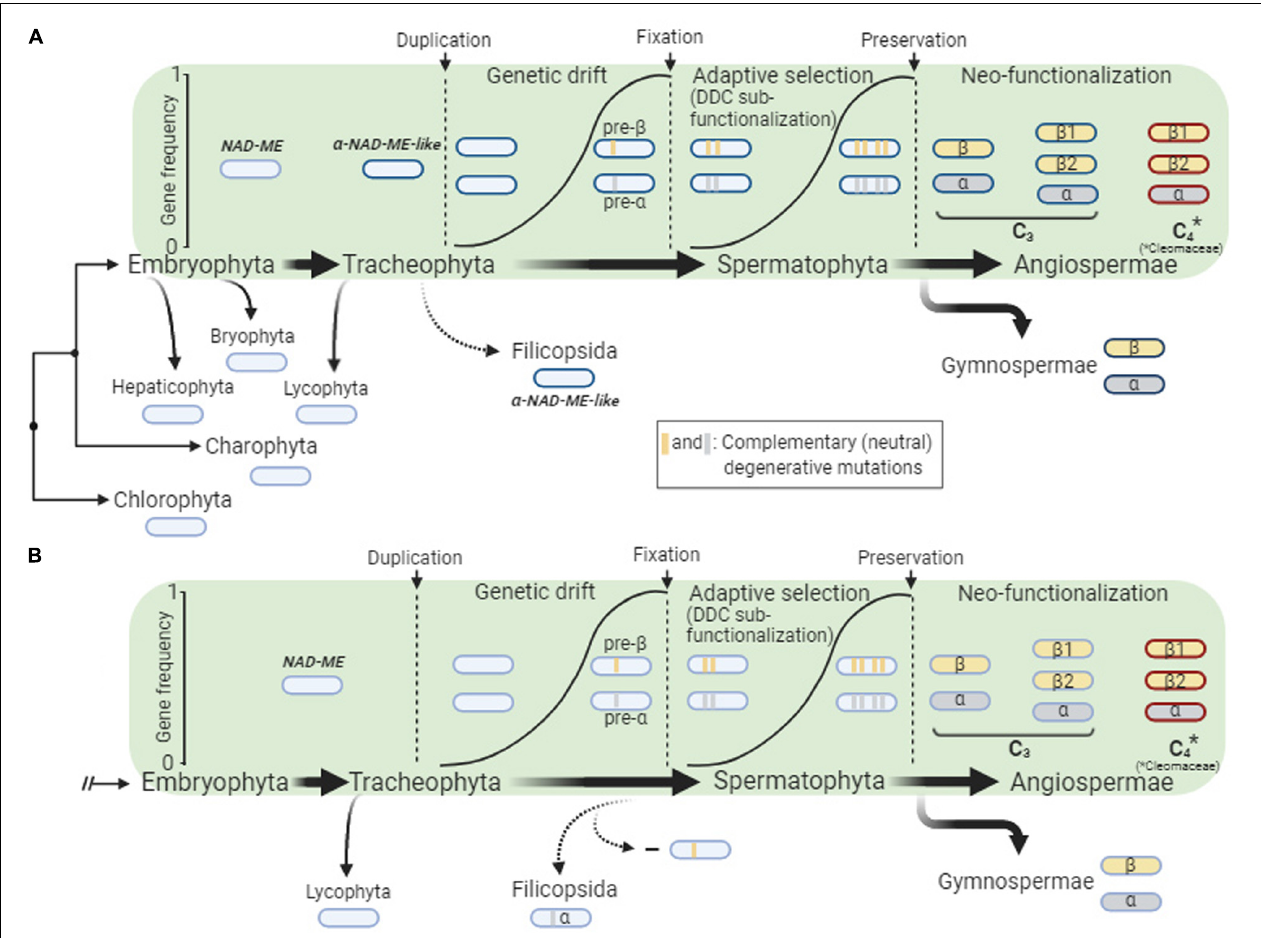
FIGURE 6 | Scheme showing our hypothesis for the evolution of the α -NAD-ME and β -NAD-ME genes in seed plants. The green panel shows the general course of the gene duplication event and the frequency of the both genes in the population until their fixation (genetic drift) and preservation (adaptive selection). The NAD-ME duplication took place late during the evolution of vascular plants, as the α - and β -NAD-ME paralogs were not found in Lycophytha, an early branching division of Tracheophyta. After that, one possible scenario is that one α -NAD-ME-like gene lineage was duplicated and fixed in seed plants but not in ferns, which kept a single copy (A) . Alternatively, the NAD-ME duplication could have occurred before Filicopsida and Spermatophyta split and the pre- β -NAD-ME copy was lost in ferns, as no selective pressure was exerted at that point (B) . In seed plants, adaptive selection through a duplication-degeneration-complementation (DDC) sub-functionalization process gave rise to the α - and β - NAD-ME gene lineages. Once preserved, both paralogs were double down and split, providing raw material for functional innovations.